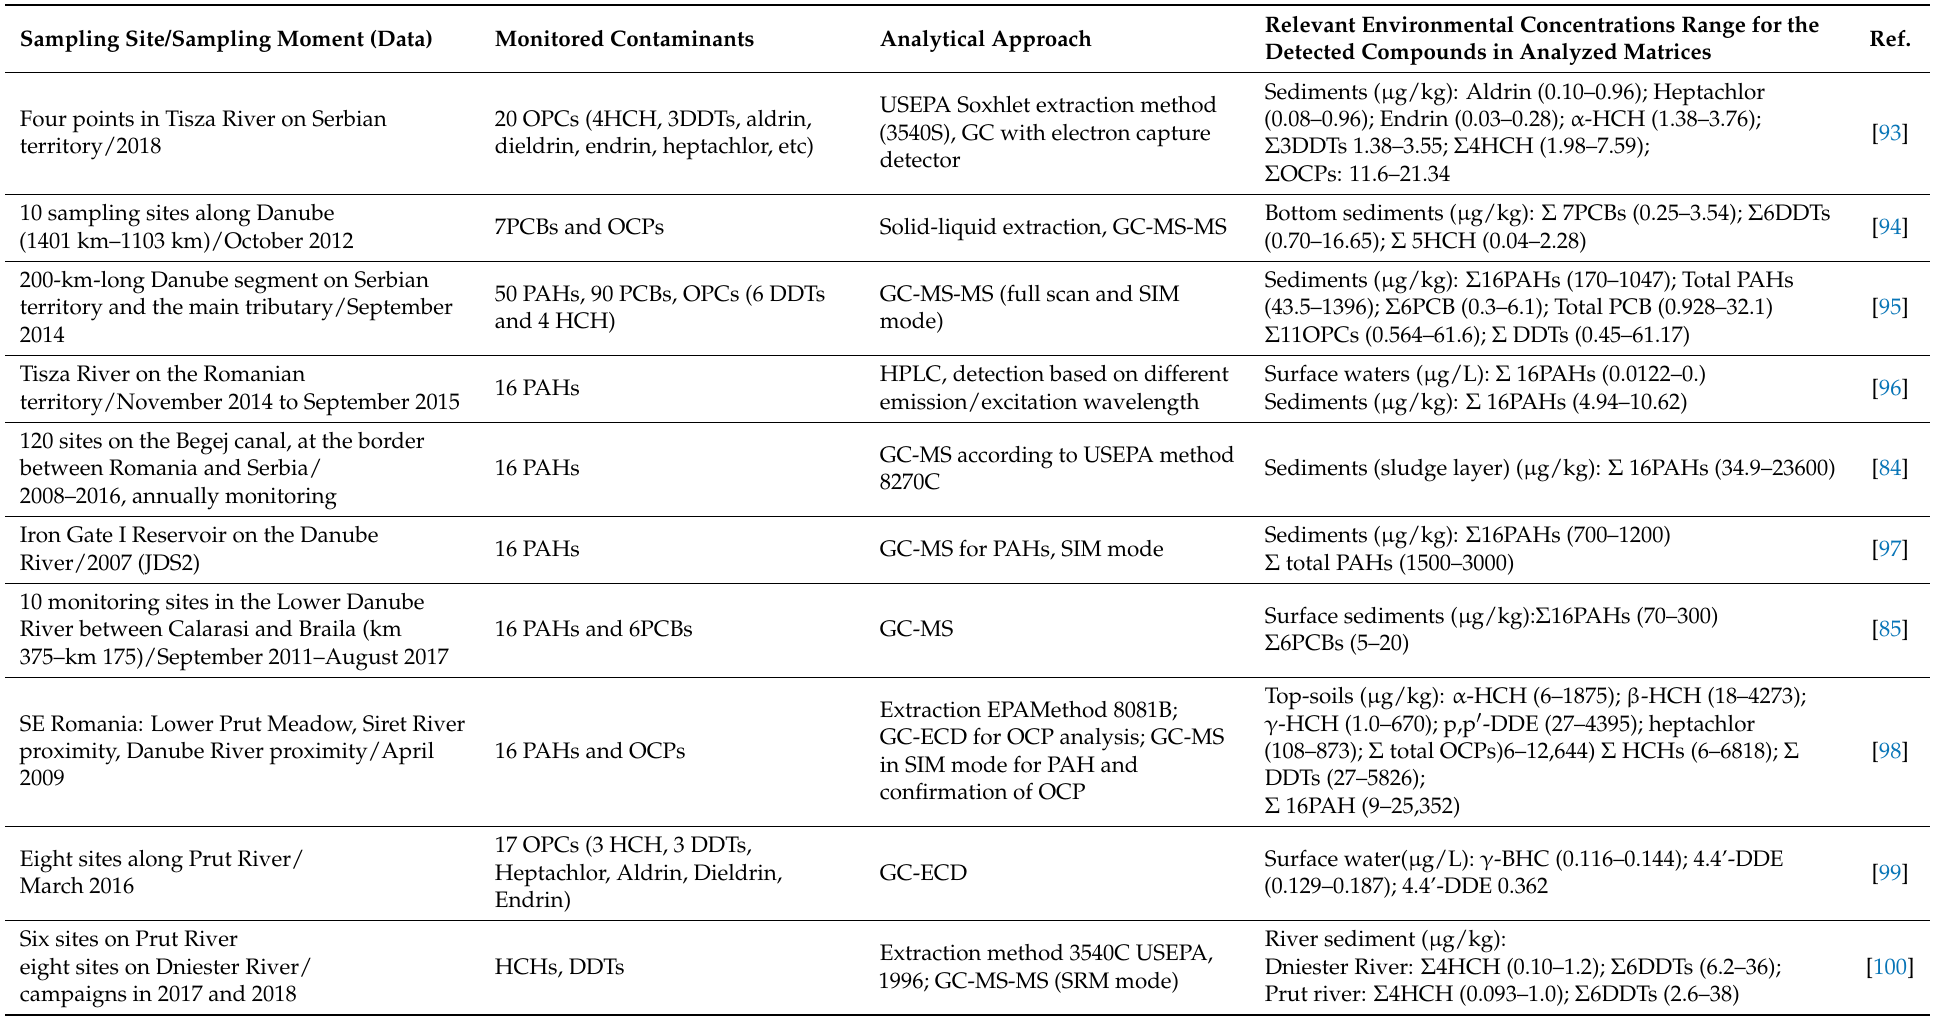
Table 4. Summary of the publications during 2010–2021 on the area of Low Danube and North-West Black Sea Basins concerning